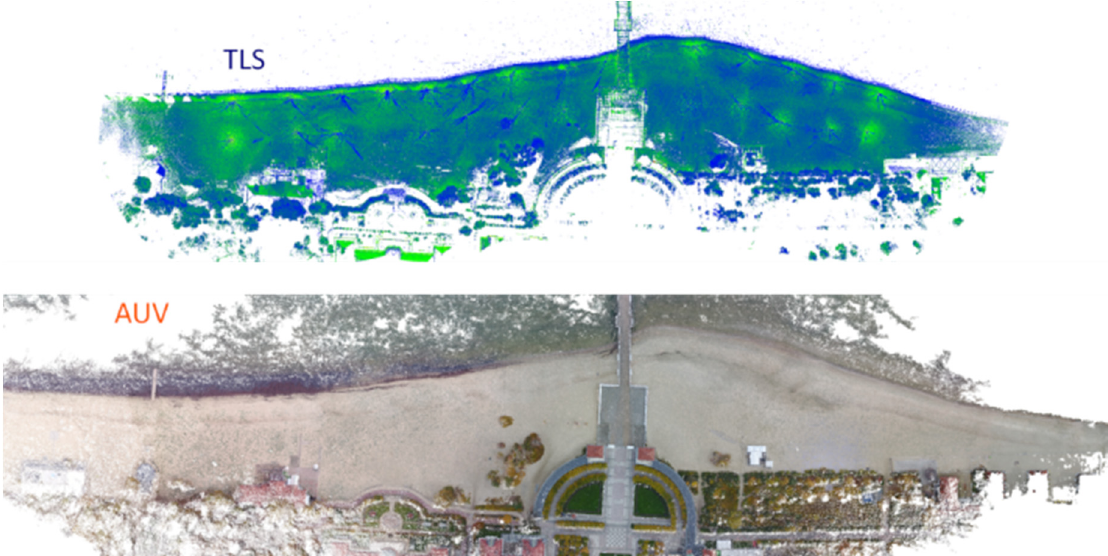
Figure 11. 3D model of the area adjacent to the Sopot pier, obtained using an unmanned aerial vehicle (UAV).